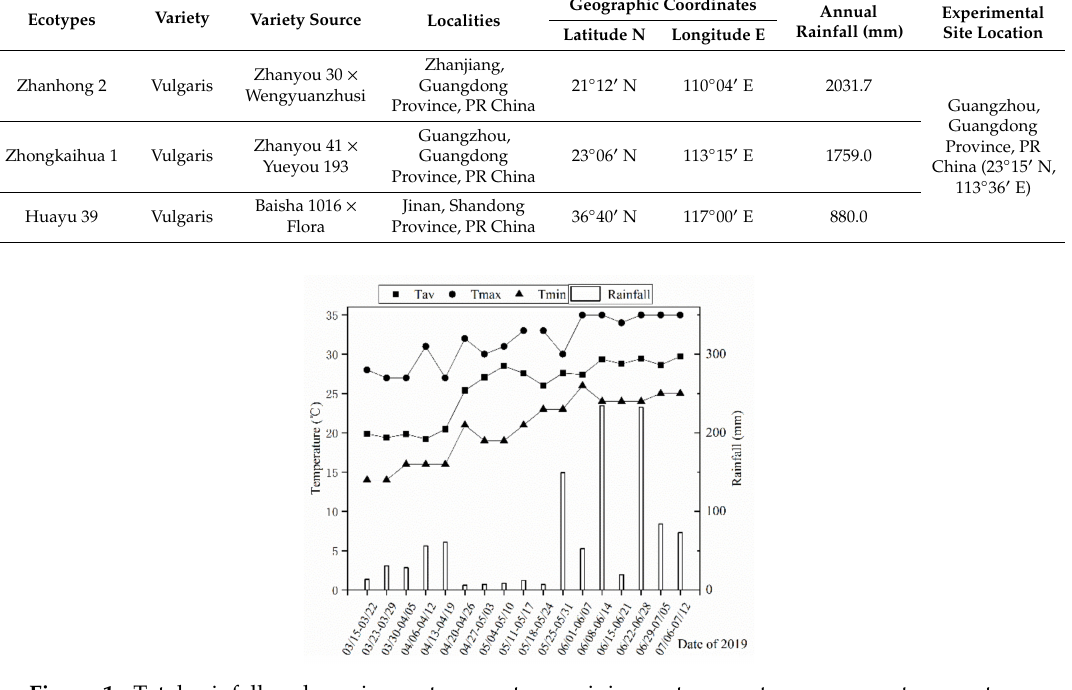
Figure 1. Total rainfall and maximum temperature, minimum temperature, average temperature, and rainfall per week during the peanut growing season at Guangzhou, Guangdong, China, in 2019. Tav: average temperature; Tmax: maximum temperature; Tmin: minimum